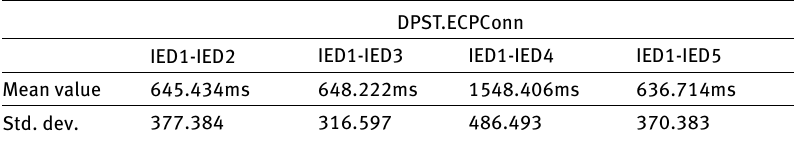
Table 1: Mean and standard deviation round trip